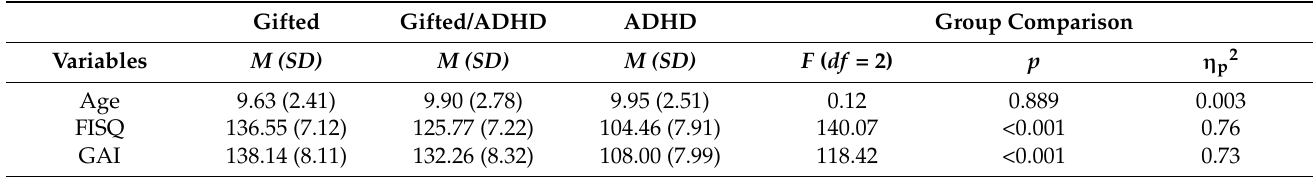
Table 1. Mean (and standard deviation) scores for IQ and age in different groups and results of group